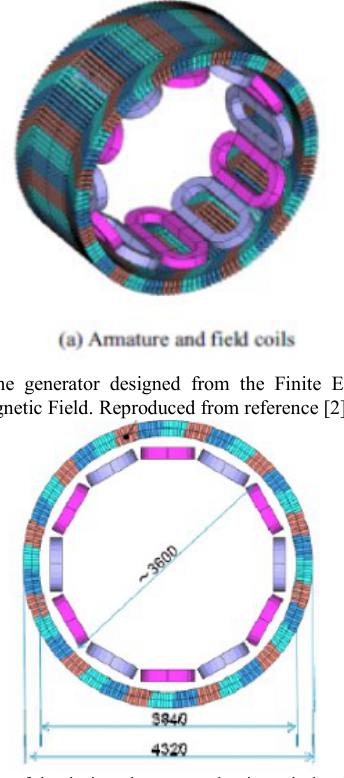
Fig.3 Dimensions of the designed superconducting wind turbine generators. Reproduced from reference [2]